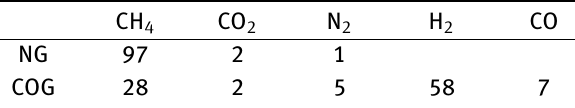
Table 6: Chemical composition of NG and COG (vol.%)